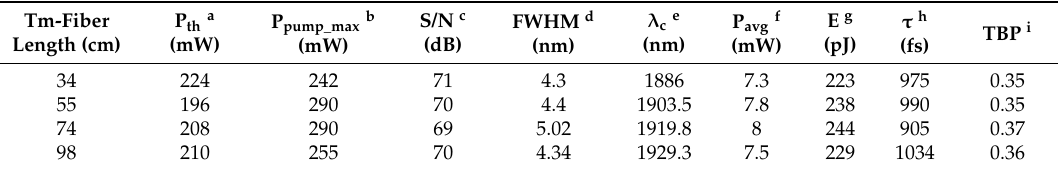
Table 4. Summary of the of the achieved laser